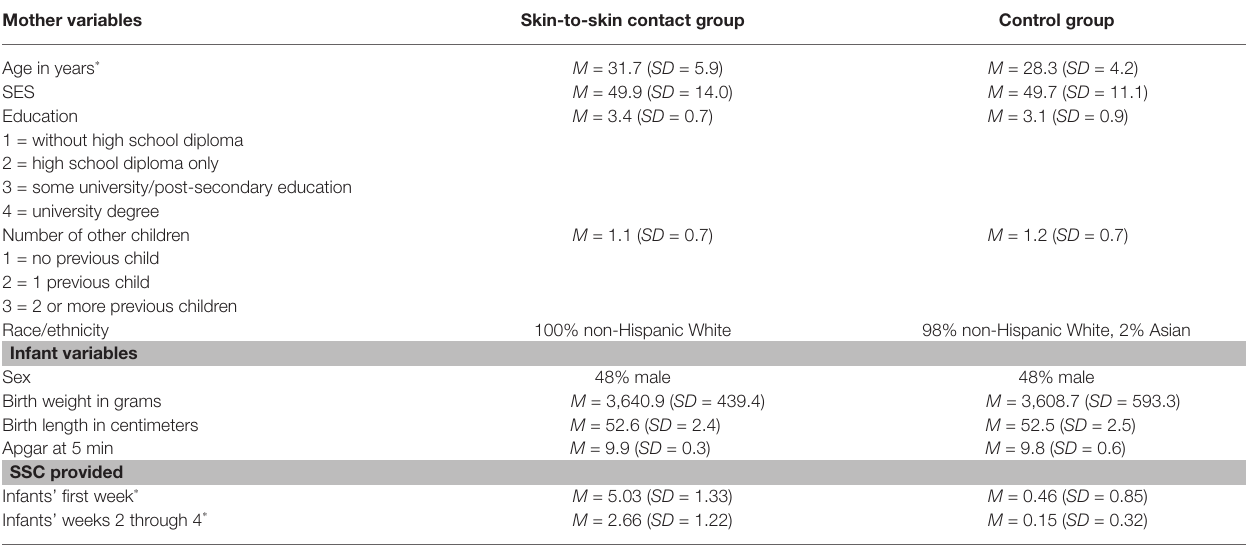
TABLE 1 | Demographics of the mothers and infants in the skin-to-skin contact (SSC) and control groups and SSC hours/day provided in the infants’ first week and weeks 2 through